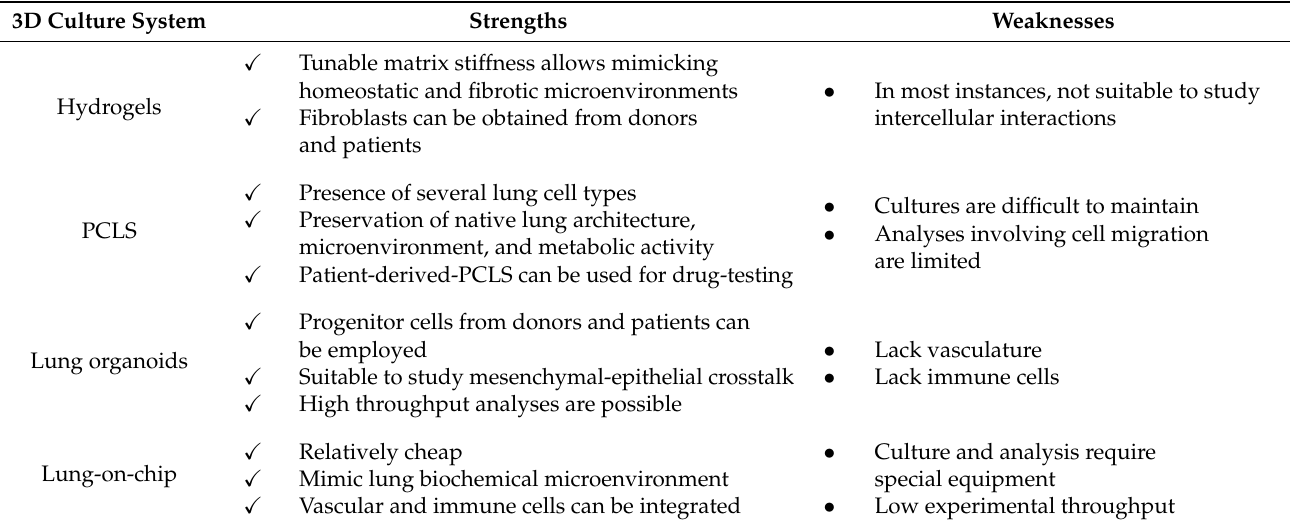
Table 2. Main strengths and weaknesses of hydrogels, PCLS, lung organoids, and lung-on-chip